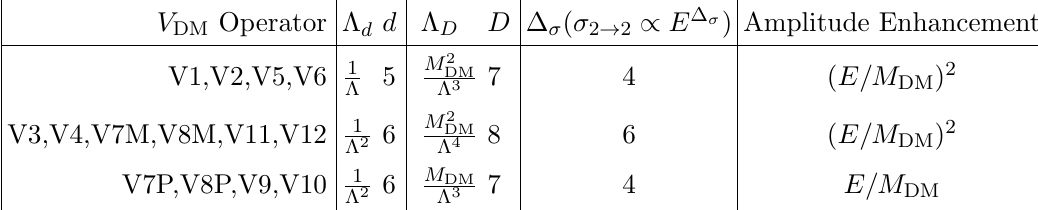
The values of d , D ,(cid:1) (cid:27) and the amplitude enhancement factors for qq ( gg ) ! DMDM process together with the new parameterisation for each V DM operator characterised by (cid:3) D in comparison to (cid:3) d from the old parameterisation. Below we omit D from (cid:3) D subscript and will denote it as (cid:3) (cid:17) (cid:3) D